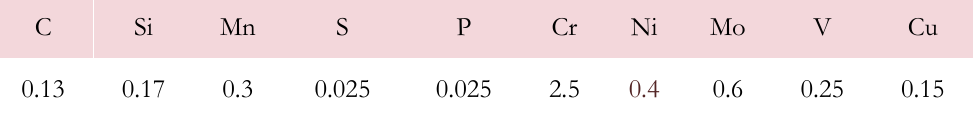
Table 1: Chemical composition of 15H2MFA steel